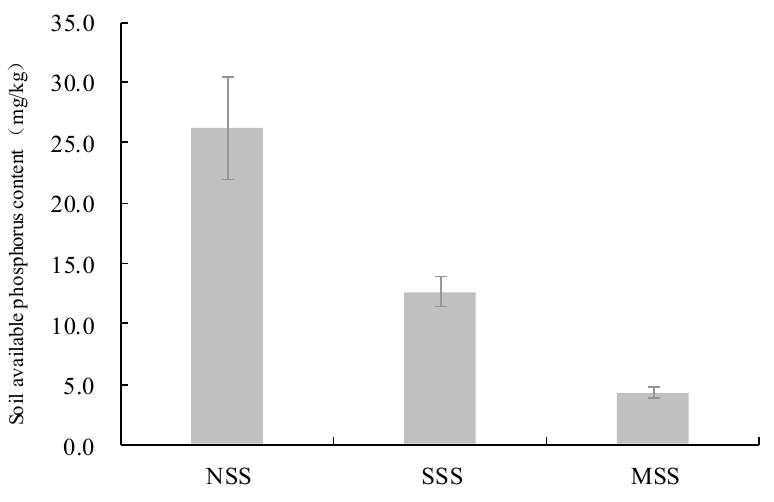
Figure 1. Soil available phosphorus under different soil salinity environment.